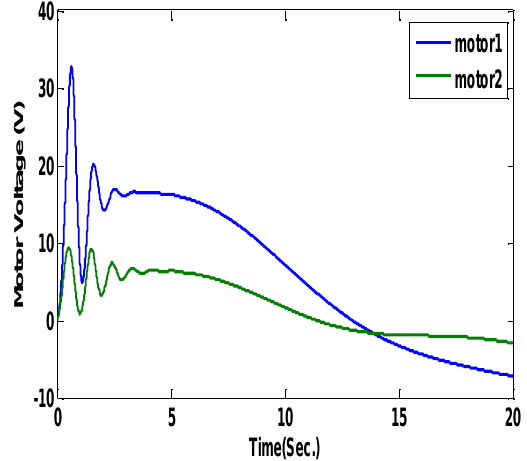
Figure 5. Control effort of proposed approach (motor voltages).